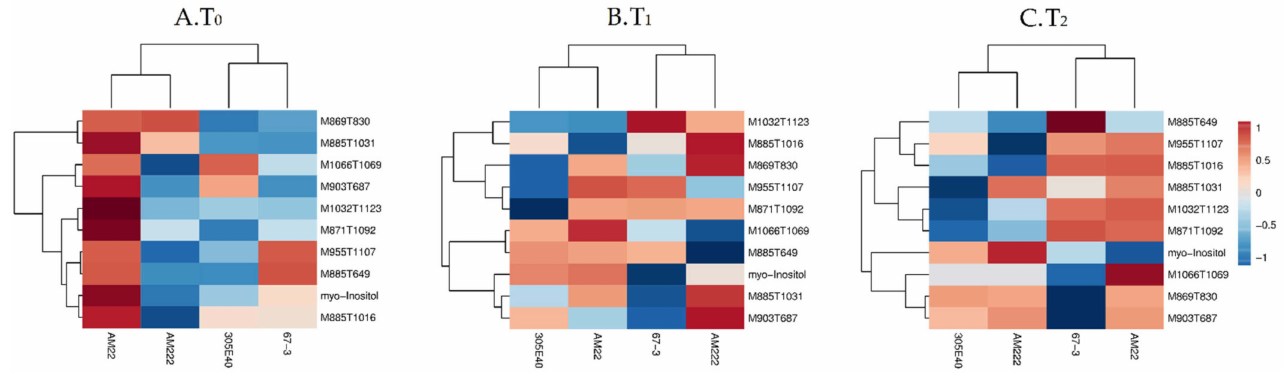
Figure 3. Heatmap of metabolites significantly differentially abundant among genotypes in root (one-way ANOVA and post hoc with p ≤ 0.05). Each column and row represent a sample and a metabolite, respectively. Comparison among genotypes shows that the main differences are in the secondary metabolites at T 0 ( A ), T 1 ( B ), and T 2 ( C ).